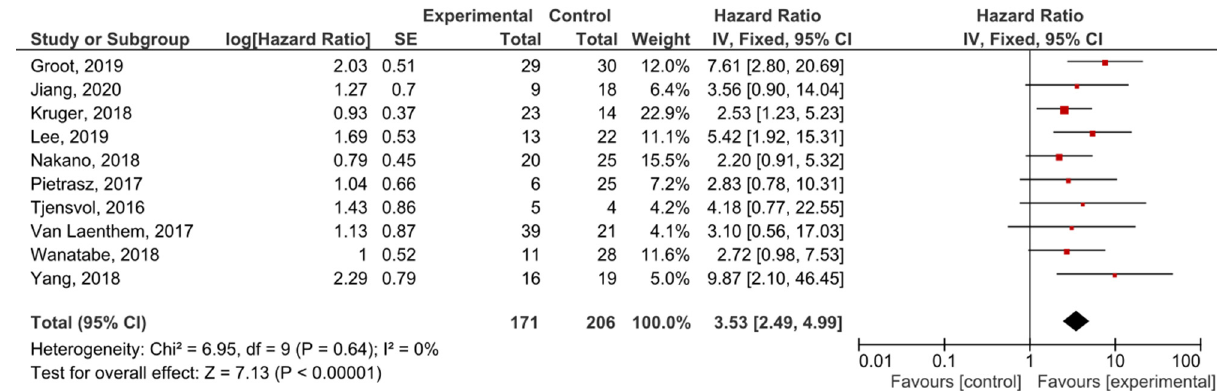
Figure 6. Forest plot presenting the relationship between the presence of KRAS mutations after treatment in PDAC patients and PFS.